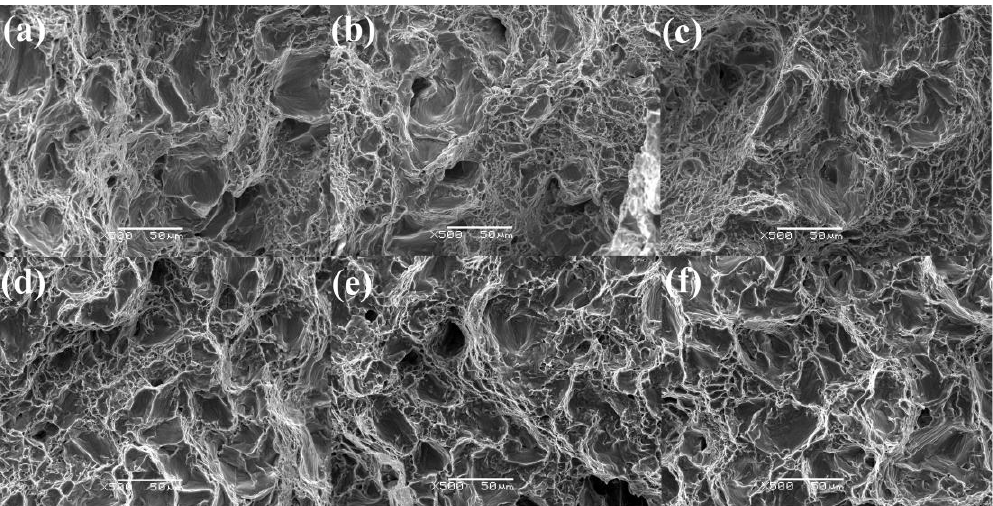
Figure 18. Micrographs of fractured surfaces of prestrained CP-Ti: ( a ) 1% prestrained; ( b ) 3.5%